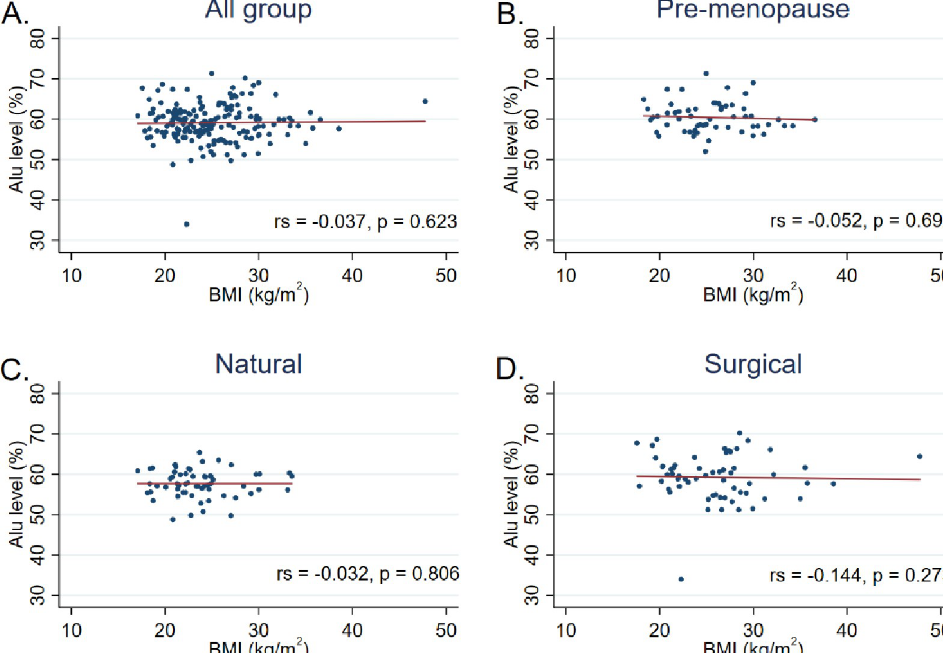
Fig 2. Correlation between the Alu methylation level and BMI among A) all participants, B) pre-menopause group, C) natural menopause group, and D) surgical menopause group. Data were analyzed using Spearman’s correlation analysis.